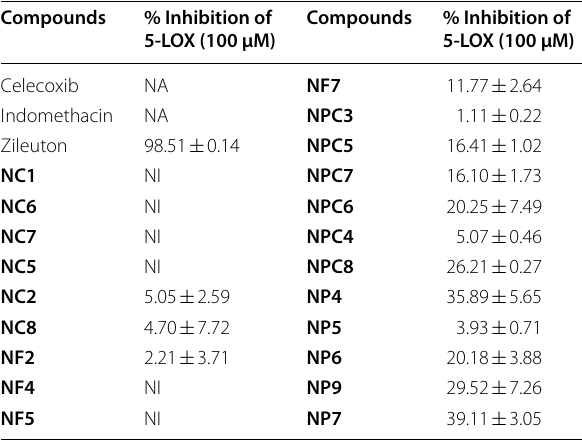
NA Not applicable; NI No inhibitory activity